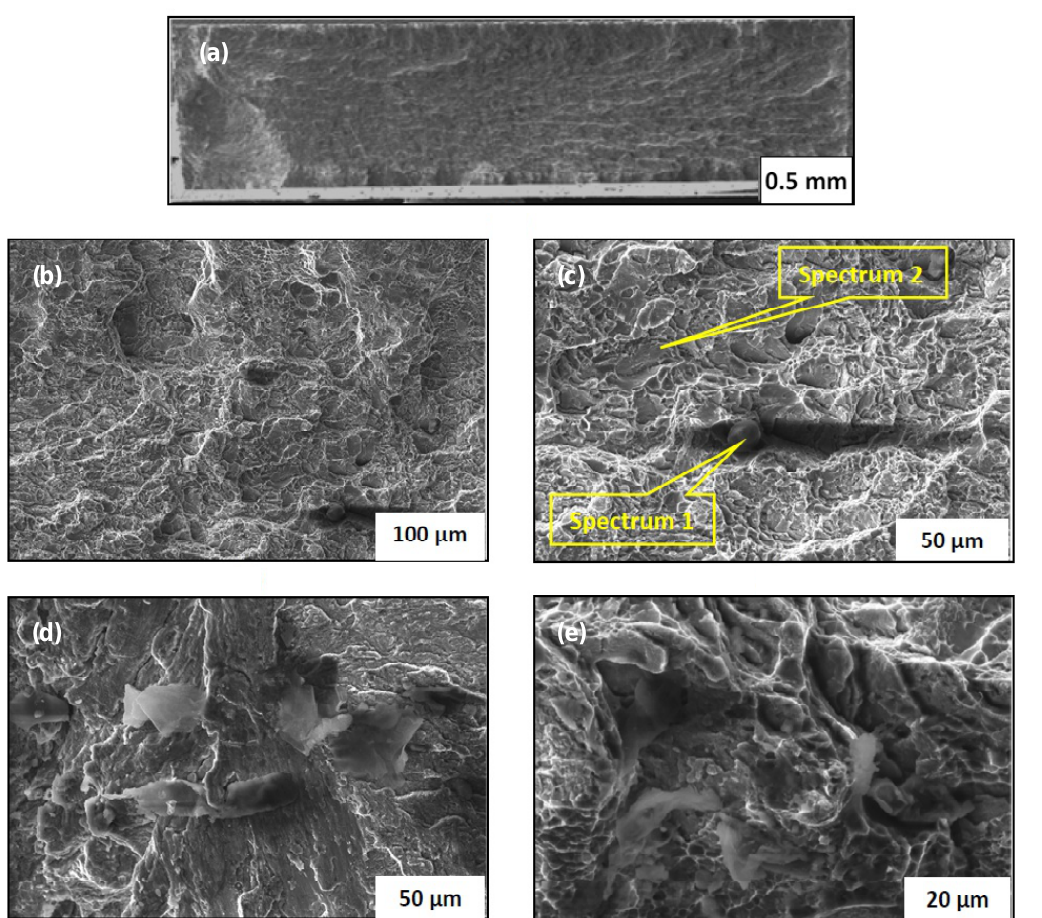
Fig. 7. General view of fractured specimen (a) and details of fractured zone for (b, c, d, e) for nanostructured LFW titanium after tensile testing. In (c) there are shown points for EDS